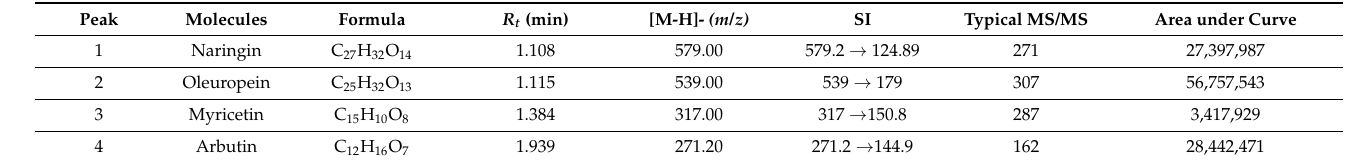
Table 1. LC-MS/MS identification composition of P. sativum Hoffm. hydro-ethanolic extract.